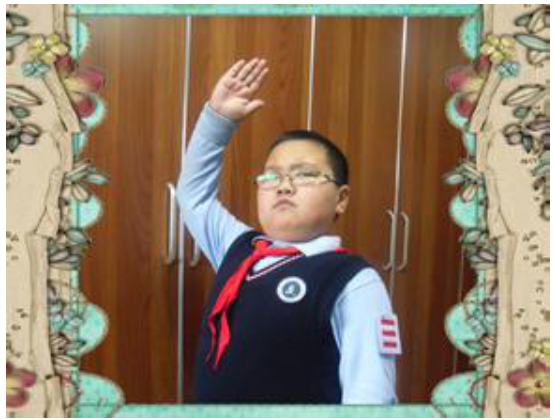
Picture 1. A boy wearing red scarf and three bars. Picture is from an online